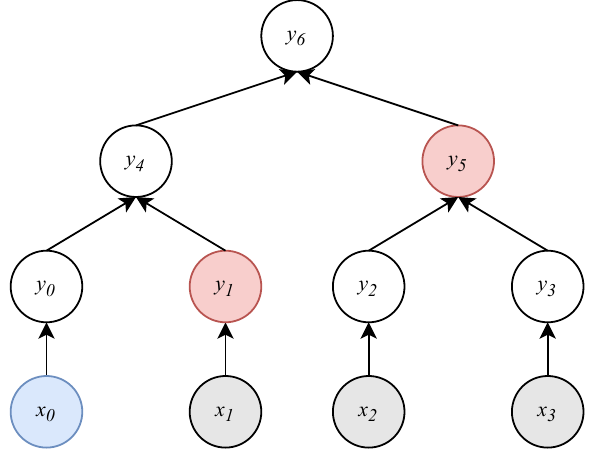
Figure 1. Merkle tree of height two. Each value of the parent node is the hash of the concatenation of its children, such as y 4 = hash ( y 0 | y 1 )